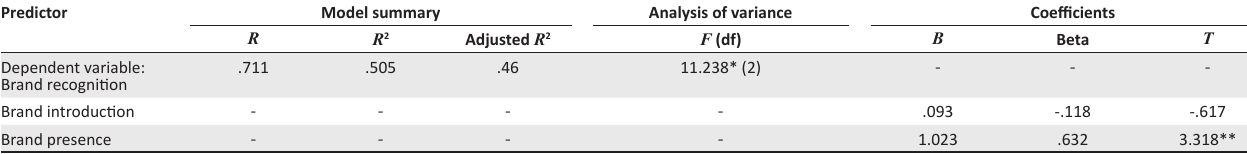
TABLE 1: Regression of brand recognition, brand introduction and brand presence. Predictor